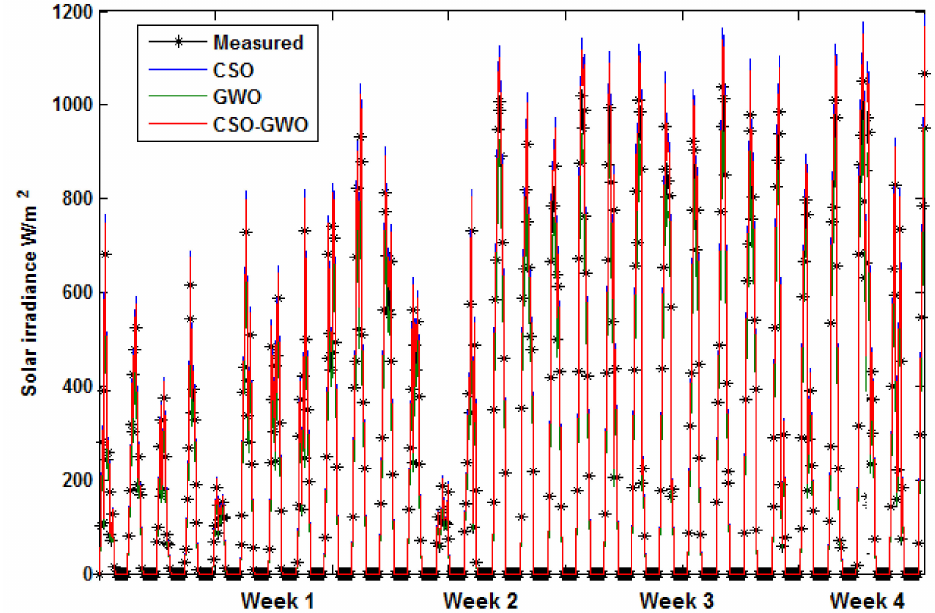
Figure 9. Weekly prediction of solar irradiance using CSO, GWO, and hybrid CSO-GWO with LSTM predictor for the weeks of December